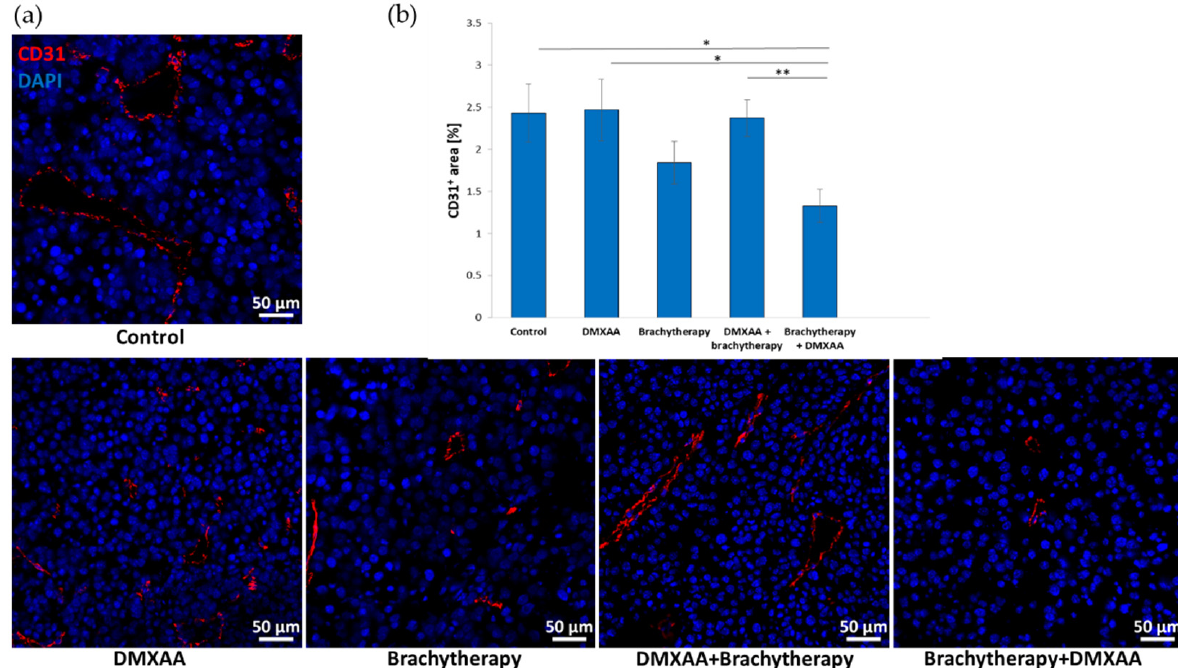
Figure 3. Effect of combination therapy on tumor vascularization. Twenty days after tumor inoculation tumors were collected. ( a ) Tumor sections were stained with anti-CD31 antibody. CD31 positive endothelial cells (Alexa Fluor 594, red) and nuclei (DAPI, blue) were visualized using confocal microscope. Photographs were taken in 5 randomly chosen fields (magn. 20 × ) per section in at least 4 tumors of each group. Representative photographs are shown. ( b ) Percentage of tumor area covered by blood vessels was calculated (mean ± SEM), * p < 0.05, ** p < 0.01 Kruskal–Wallis multiple comparisons.